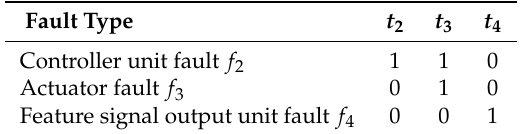
Table 2. Simplified dependency matrix of the control